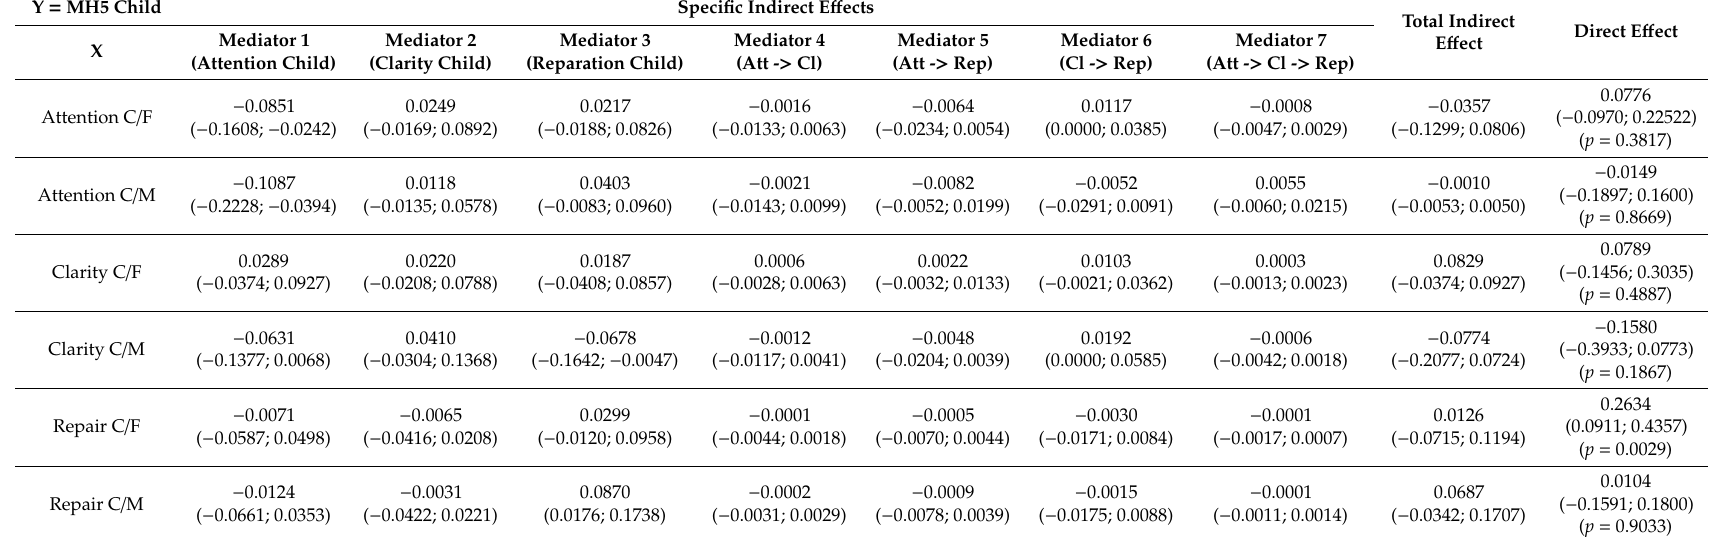
Table 5. Indirect and direct e ff ects for the mediation model using EI perceived by children about parents as explanatory